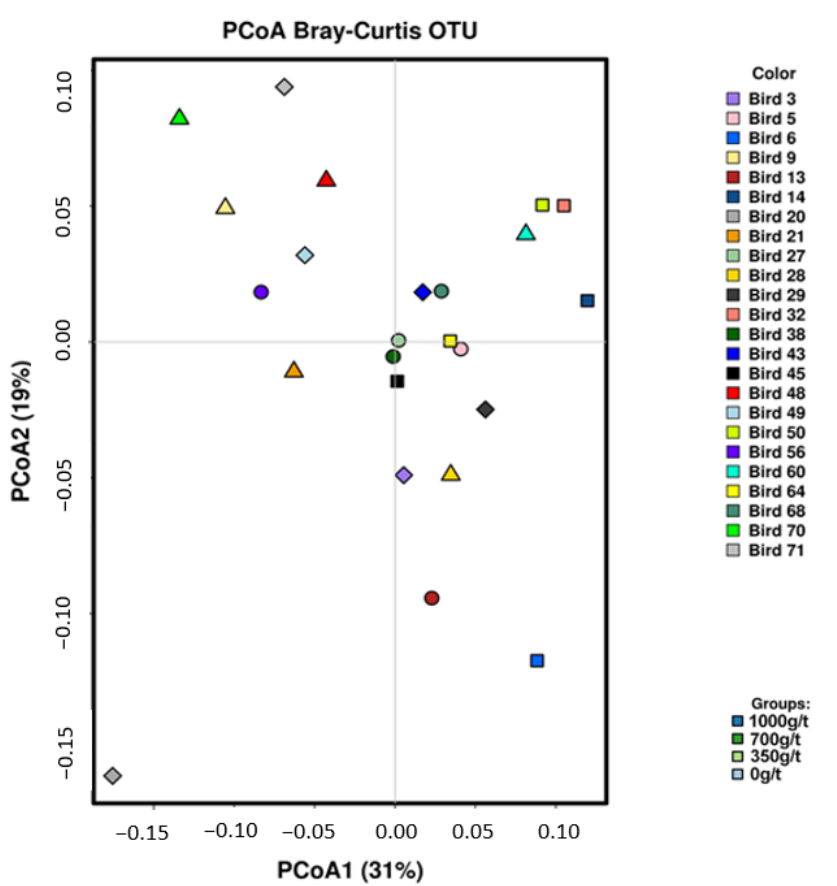
Figure 4. Principal coordinate analysis (PCoA) of microbiota based on Bray–Curtis distance for OTUs.